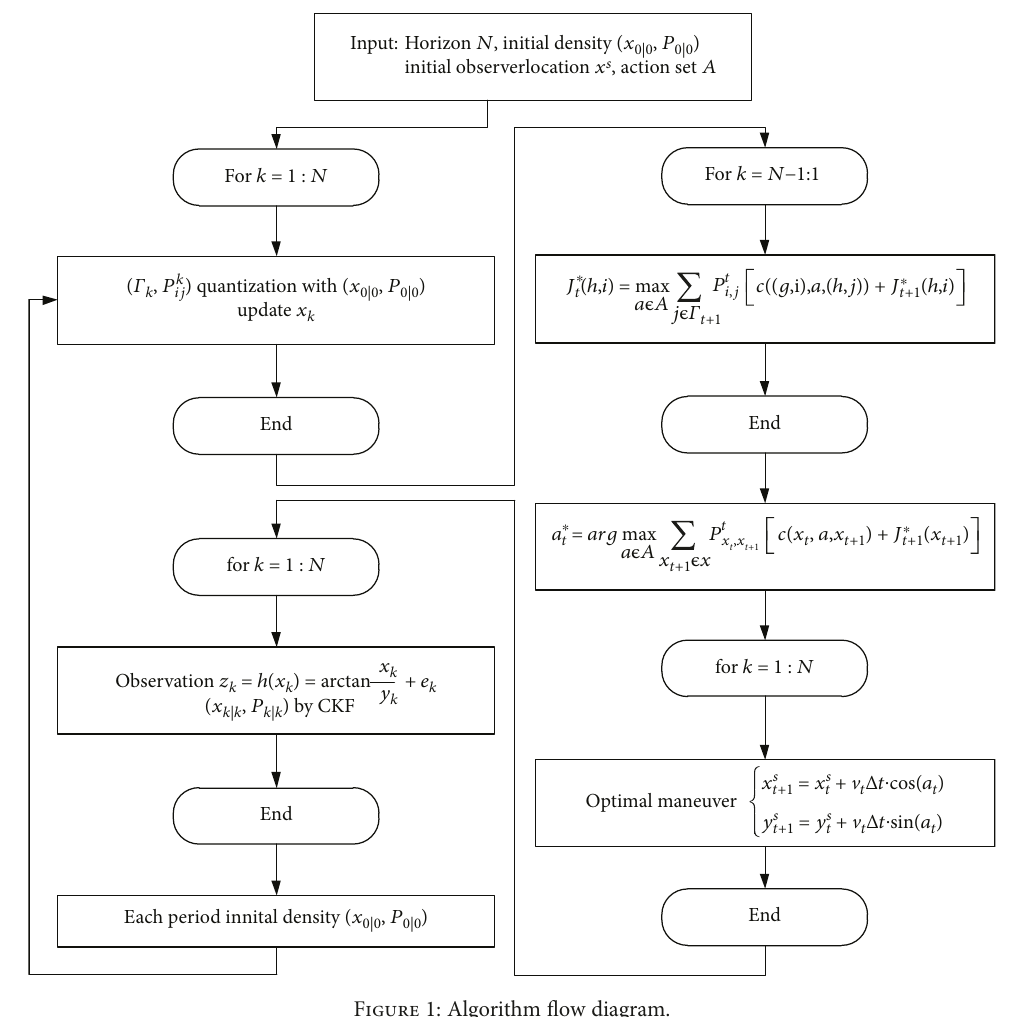
Figure 1: Algorithm fl ow diagram.